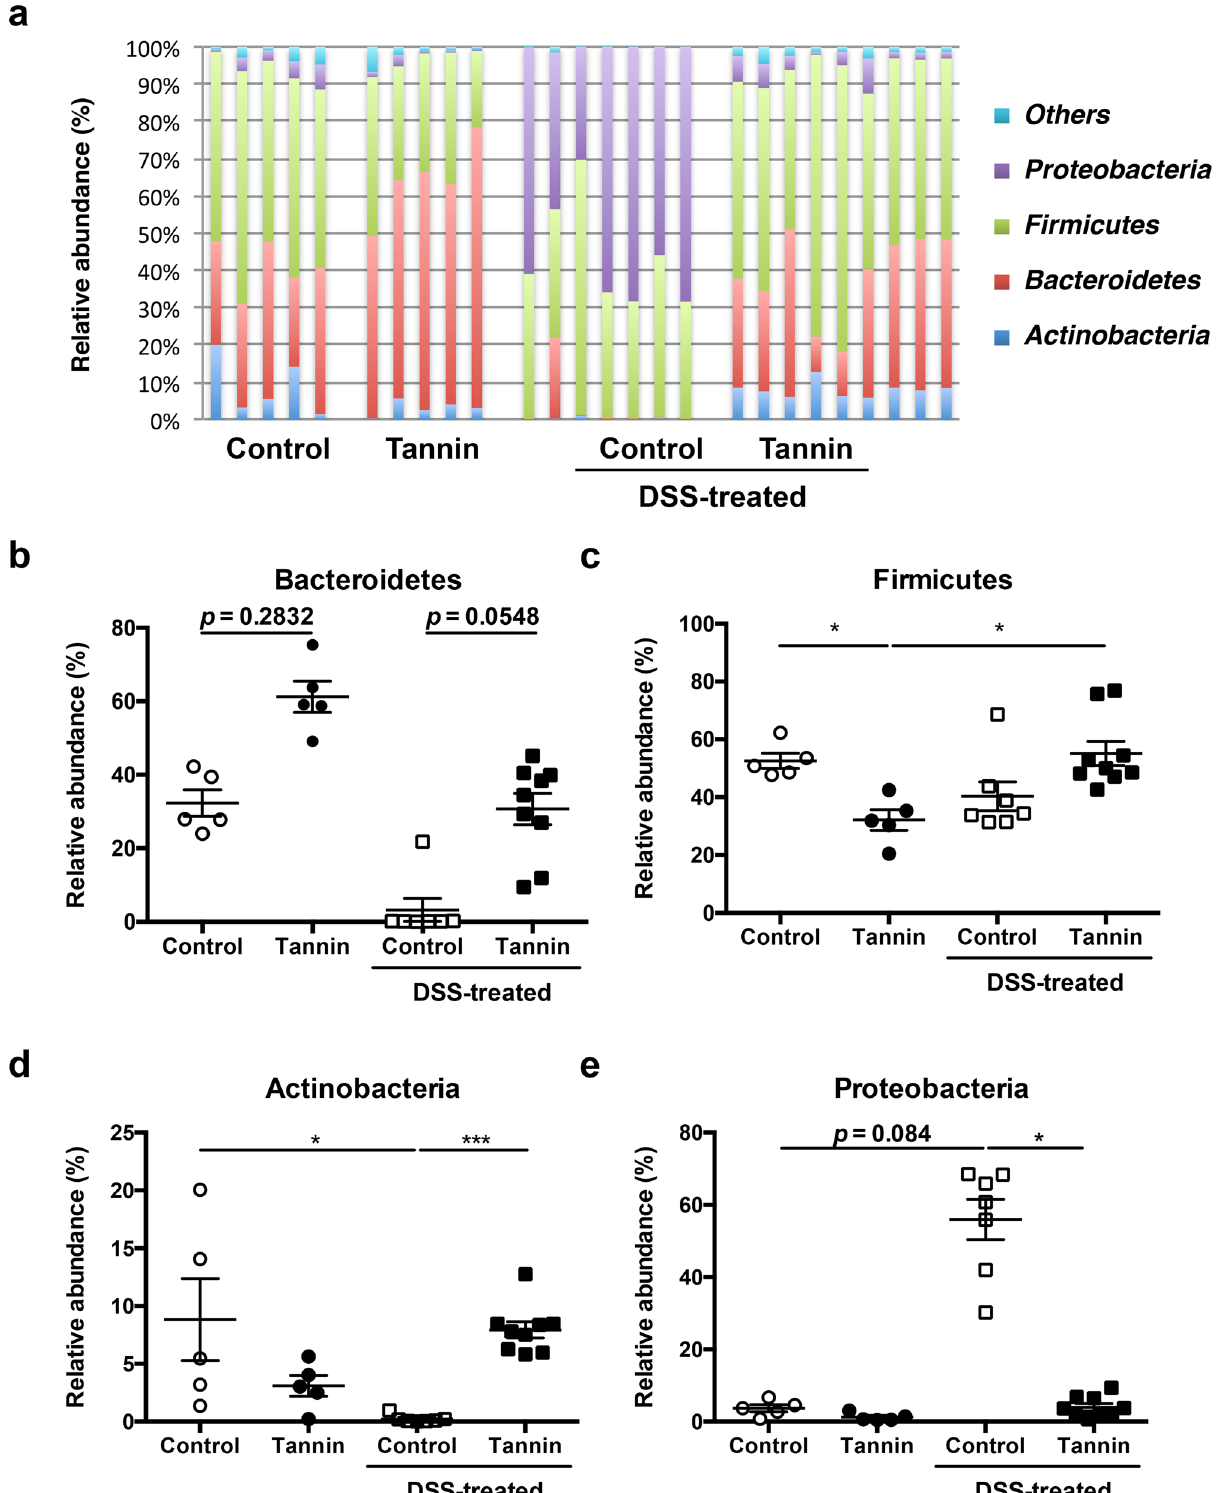
Figure 5. Dietary supplementation of persimmon-derived tannin alters the proportion of bacteria at the phylum level in colitis-induced mice. ( a ) Relative abundances of major phyla of faecal bacteria in untreated and DSS-treated mice fed the control or tannin-supplemented diet were analysed by 16S ribosomal RNA gene sequencing and shown in individual histograms. ( b – e ) Summarised data for the relative abundance of each phylum, Bacteroidetes ( b ), Firmicutes ( c ), Actinobacteria ( d ), and Proteobacteria ( e ) are shown as the mean ± SEM with individual plots (n = 5–9). * p < 0.05, *** p <